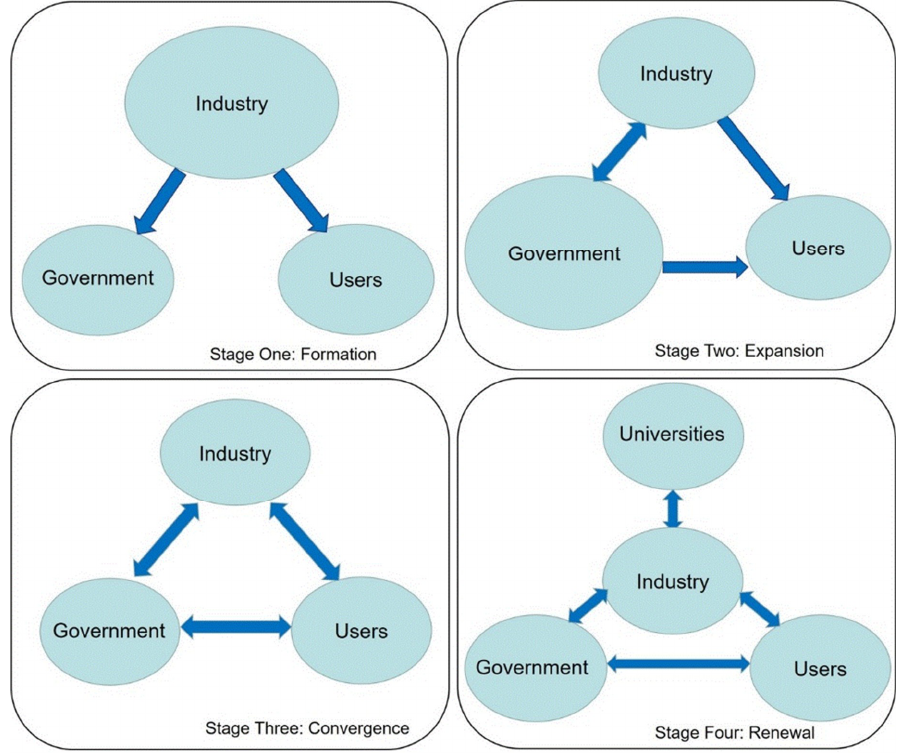
Figure 3. Industry-government-user-government interactions in a responsible innovation